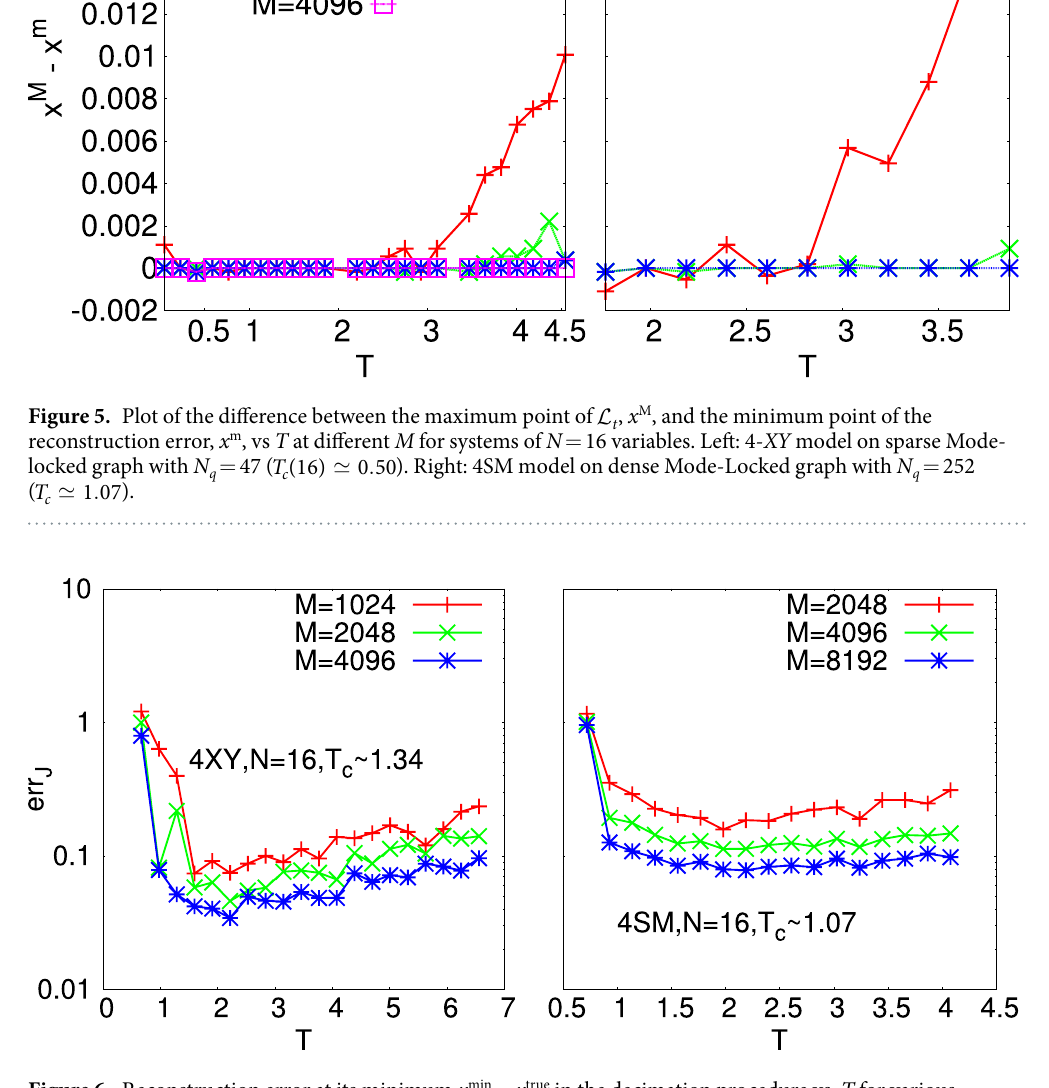
 such interval, and, more in general, the system is better and easier reconstructed. In Fig. 4, the behavior of the t versus x is compared to err J ( x ) for three different systems, the 4 XY -model on ML and ER sparse graphs and the 4SM-model on a dense ML graph. All systems have N = 32 variable nodes while the number of interaction quad- ruplets is N q = 32, 72 and 2360, respectively. The number of configurations in all cases is M = 65000. It is clearly , x M , coincides with the observed that, given a large enough M and/or a critical-like T the maximum point of the  t minimum point of err J , x m . The decimation PLM gives then a criterion to determine the number of interaction couplings in the system from measurements data without any a priori chosen parameters. We notice that, as M is small and T far from the critical region, the maximum point of  and minimum point of err J can be mismatched, t as shown in Fig. 5. In Fig. 6 the T dependence of err J is plotted for the 4 XY model on a ER sparse graph and for the 4SM model on a ML dense graph at different values of M . As detailed in Suppl. Mat. the critical T interval turns out to be identified by the (finite size) critical temperature estimate of the phase transition point of the direct statistical mechanical problem.